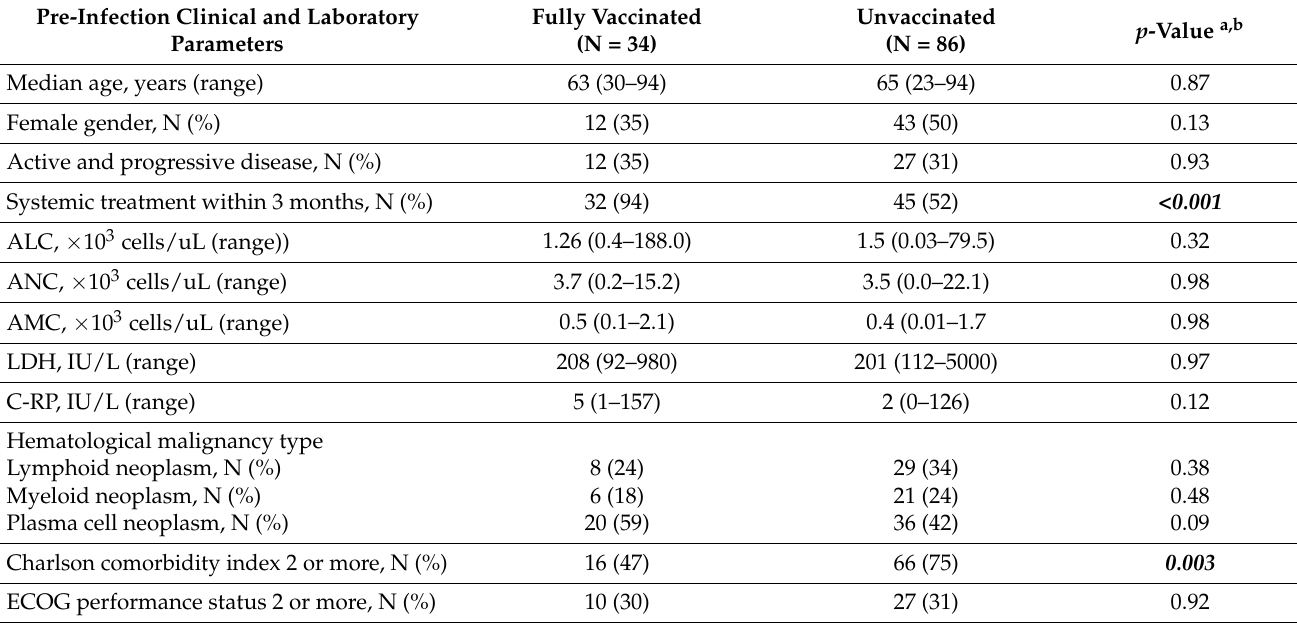
Table 1. Pre-infection clinical and laboratory parameters in hematological patients affected by COVID-19 by baseline vaccination status.